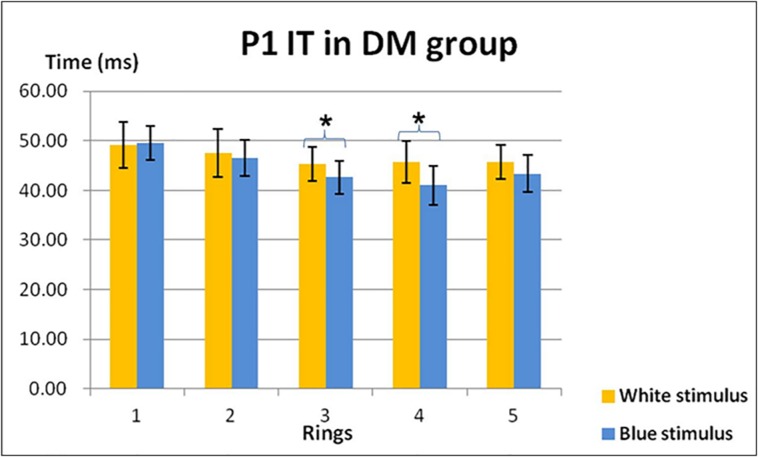
The P1 implicit time (mean ± SD) in the diabetic group under both the white and blue conditions (* indicates parameters that achieved statistically significant level with p < 0.05)